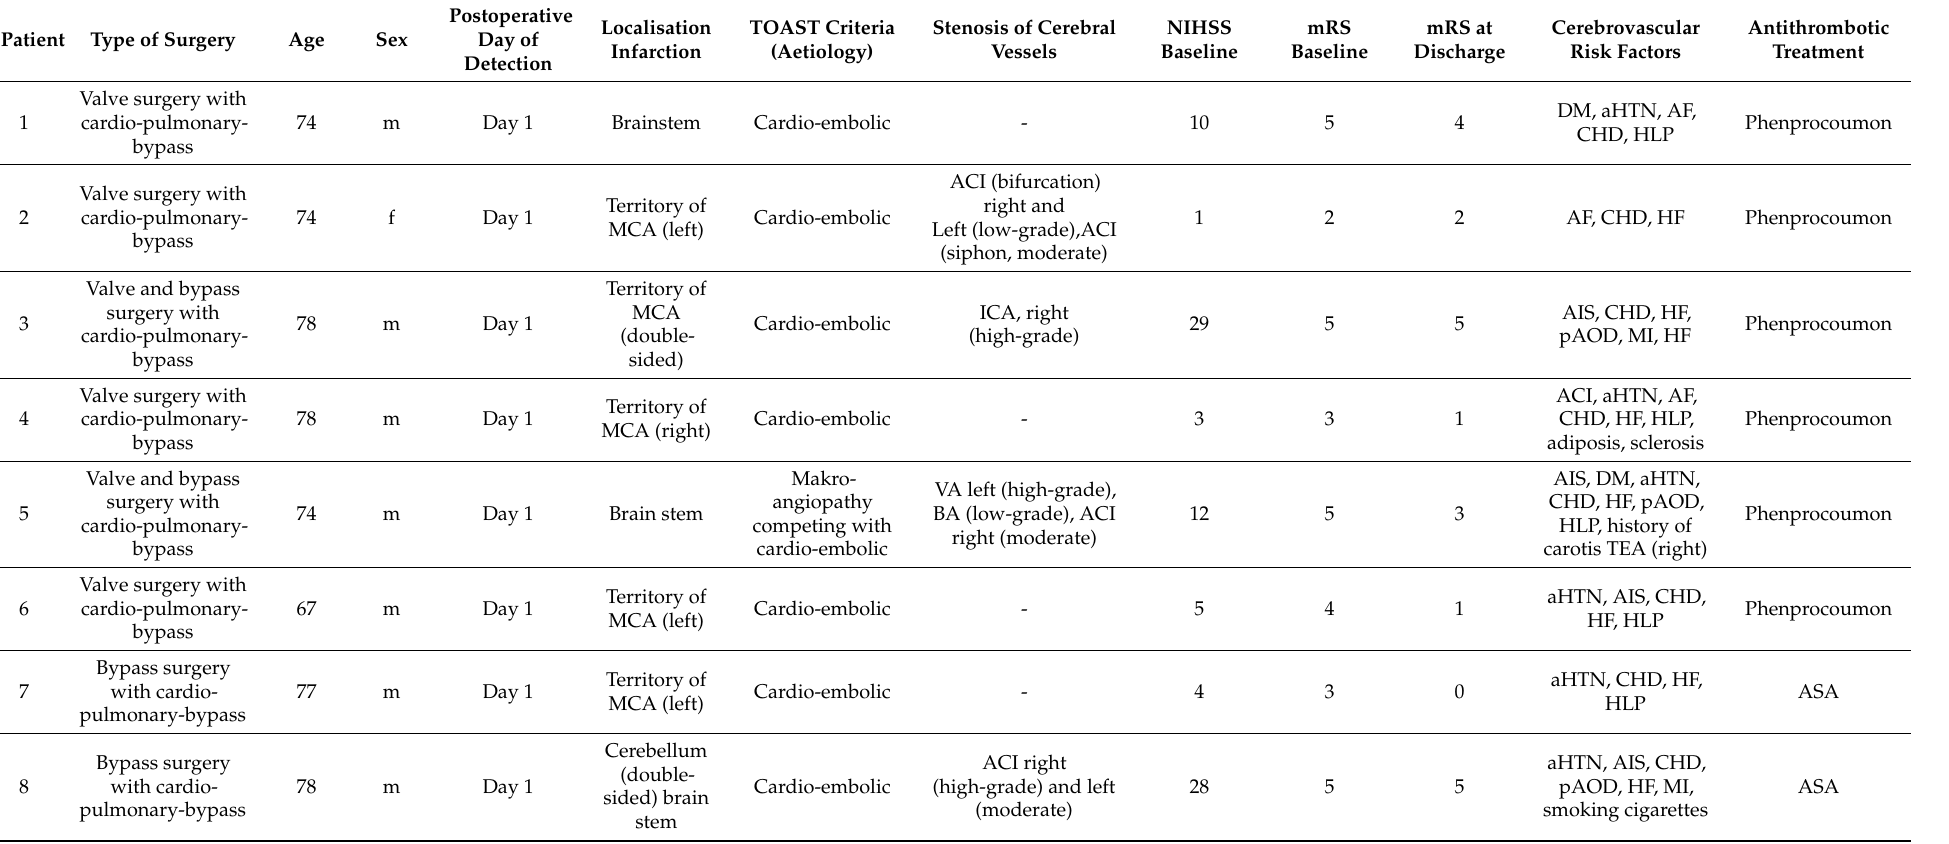
Table A4. Patients with postoperative acute ischemic stroke: aetiology, severity and risk